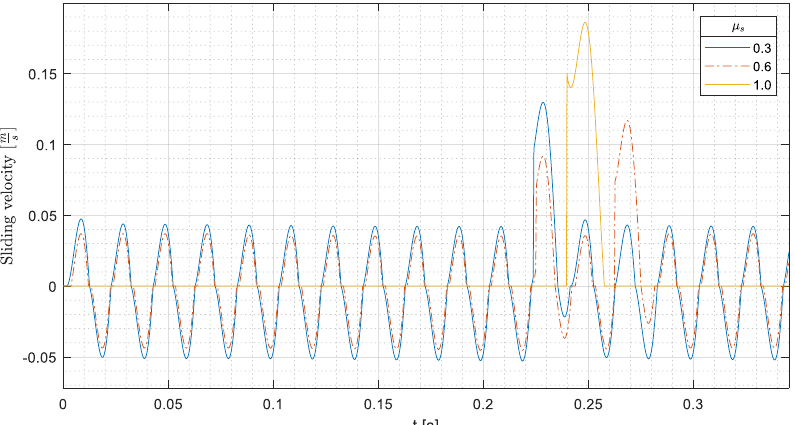
Figure 15. Numerical results, sliding velocity of the cylindrical part along the track, 𝜃 = 3° , 𝜓 = 0, 𝑓 𝑣 = 0.005 , 𝜇 𝑐 = 0.3, and parametric values of static friction coefficient 𝜇 𝑠 .